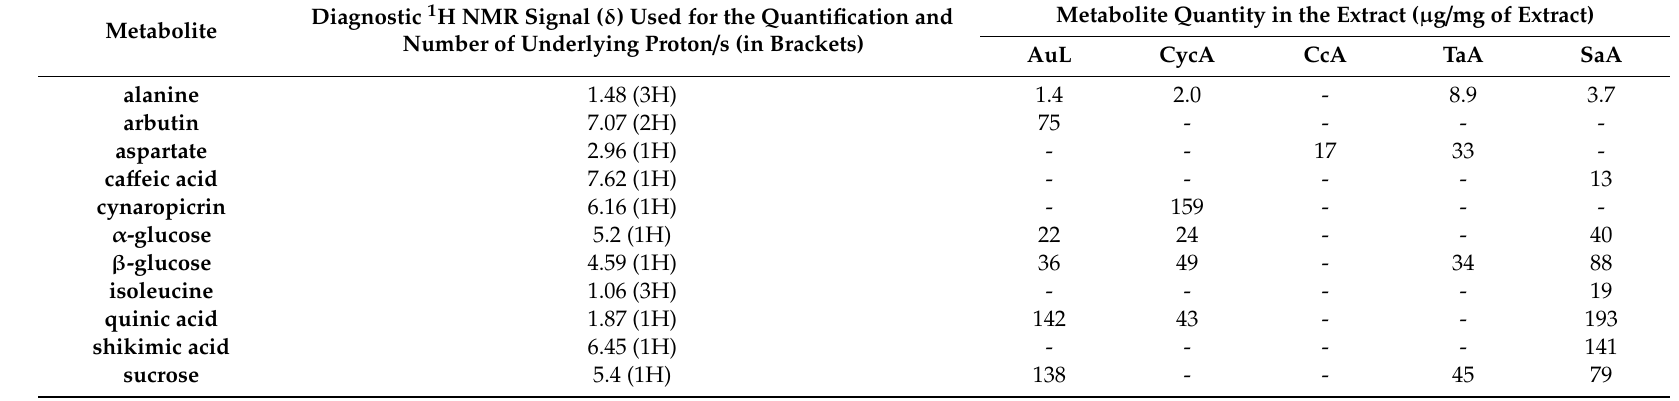
Table 3. Estimated amount of metabolites by 1 H NMR